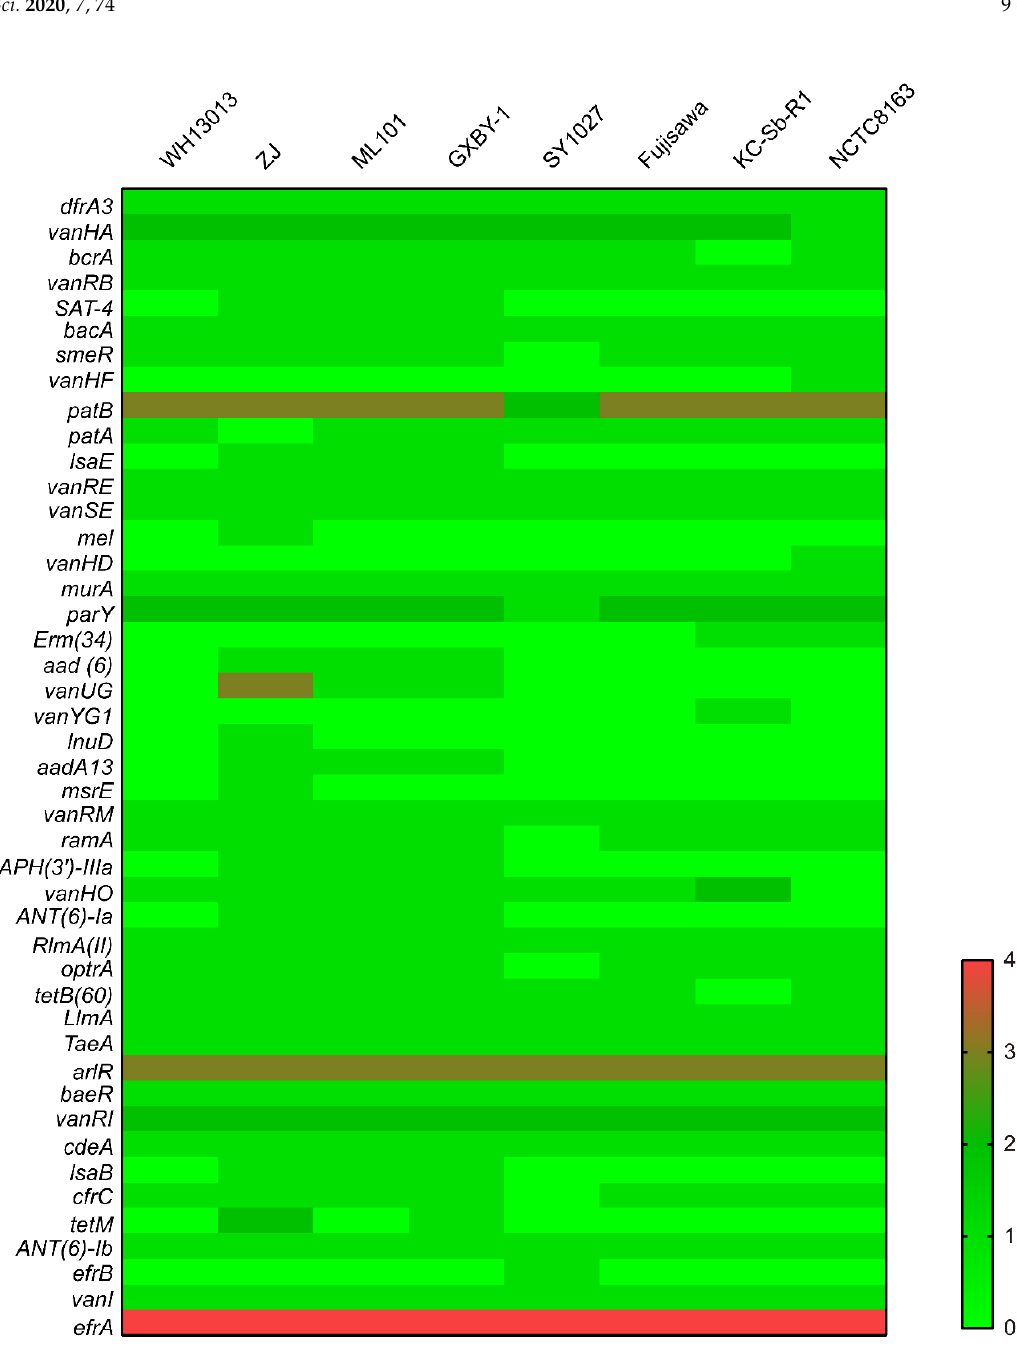
Figure 5. Heatmap showing the distribution of predicted antibiotic resistance genes in different E. rhusiopathiae strains. Copies of resistance genes found in each of the genomes were shown in different shades of colors.